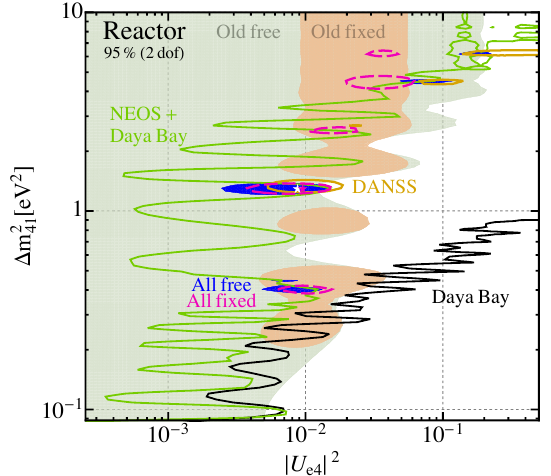
Figure 9: Combined ¯ ν disappearance results from reactors. All the parameter space e inside the coloured regions is allowed at 95% CL, and the parameter space to the right of the lines is disallowed with the same confidence level. The global combination is shown in blue for free flux normalisation, and in pink for fixed theoretical flux calculations. Figure extracted from Ref. [ 13 ] .